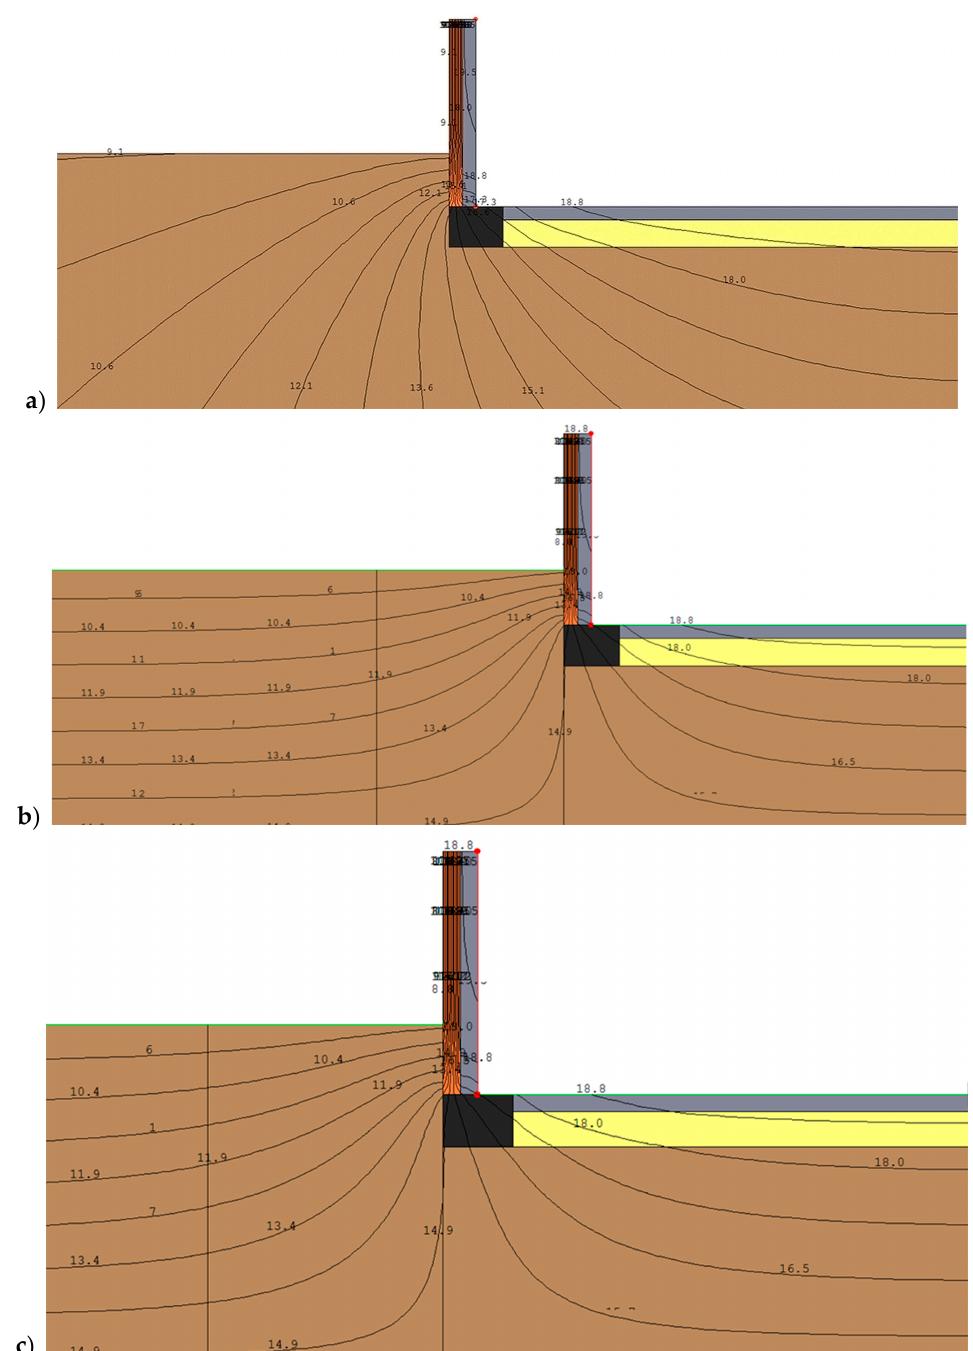
Figure 9. Distribution of isotherms: ( a ) base model W_1; ( b ) model W_2 for Profile I; ( c ) model W_3 for Profile II.